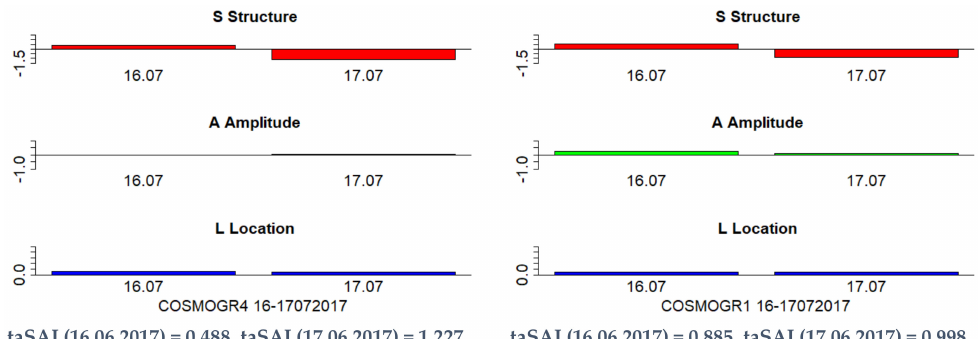
Figure 10. SAL component diagrams for the period 16–17 July 2017 for COSMOGR4 ( left ) and COSMOGR1 ( right